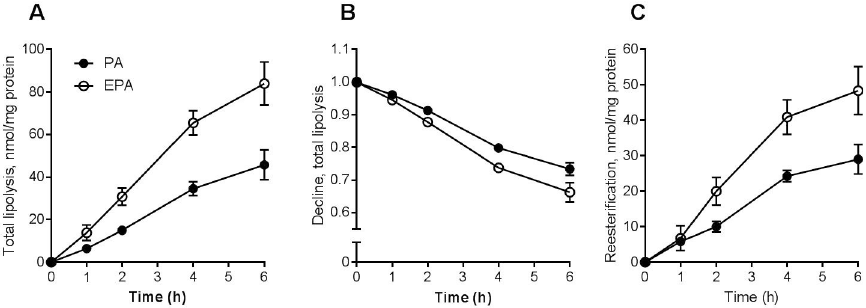
Fig 2. Lipolysis and re-esterification of oleic acid in myotubes after co-incubation with fatty acids. Human myotubes were grown and differentiated in 96-well ScintiPlate tissue culture plates. On day 6 of differentiation the myotubes were treated with a mixture of 100 μ M fatty acids for 24 h. The mixture was trace amounts of [ 14 C]OA (9 μ M) and non-labeled PA or EPA (20:5, n-3) (91 μ M). (A) Total lipolysis (lipolysis measured in presence triacsin